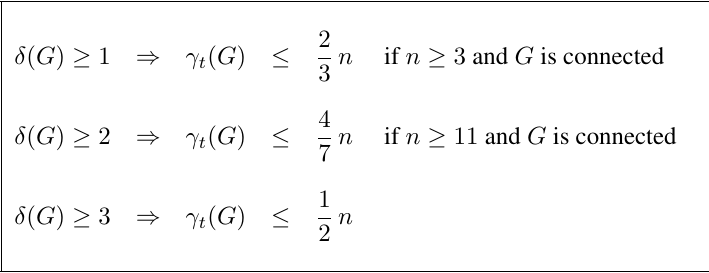
Table 1. Upper bounds on the total domination number of a graph G